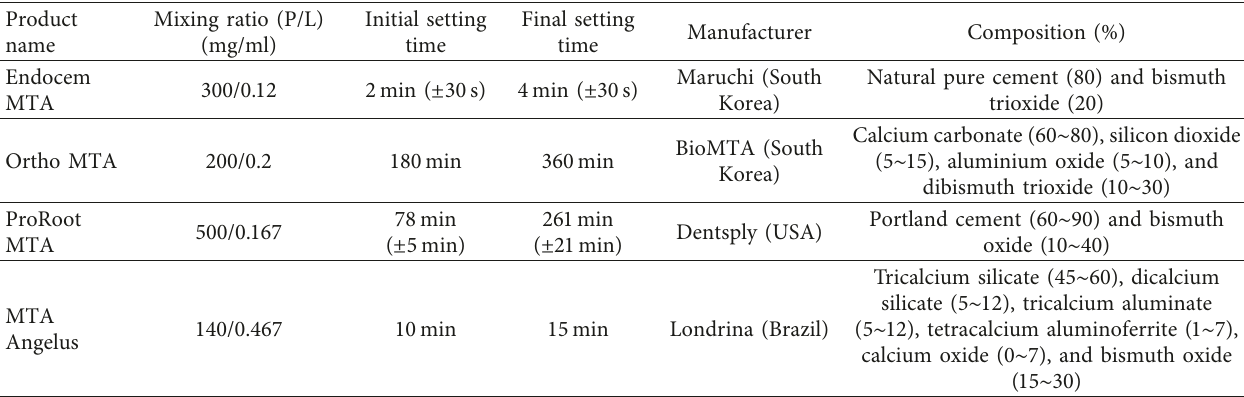
Figure 1: The methodology used in the present study. To examine cytotoxicity of MTA during setting or after setting, the MTA sample discs separated from the Teflon molds were immersed in media “during setting” (after 180 s) or “after setting” (24hr later). Table 1: The properties of MTAs used in the present